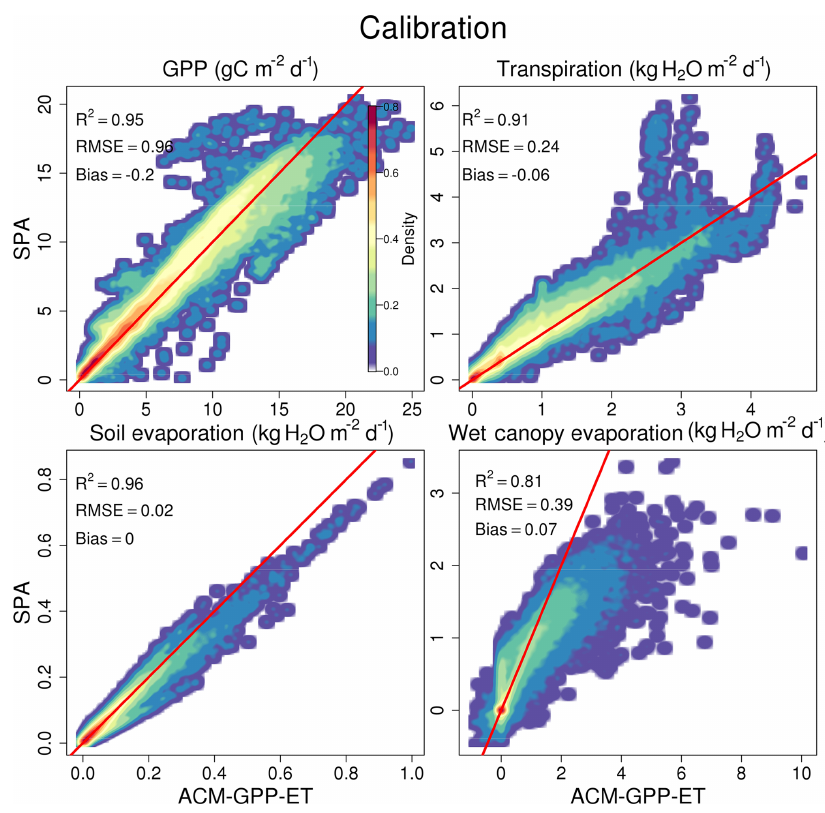
Figure 3. Comparison between SPA- and ACM-GPP-ET-generated fluxes, where ACM-GPP-ET used the maximum likelihood parame- ter sets from the calibration procedure. Fluxes compared are gross primary productivity (gCm − 2 d − 1 ), transpiration (kgH 2 Om − 2 d − 1 ), soil evaporation (kgH 2 Om − 2 d − 1 ) and evaporation of water intercepted by the canopy (kgH 2 Om − 2 d − 1 ). The red line is a 1 : 1 line for reference. The colour intensity from blue to red indicates the density of flux estimates within a given area. Note that for clarity, to show low-density areas, the density values are scaled by density 1 / 4